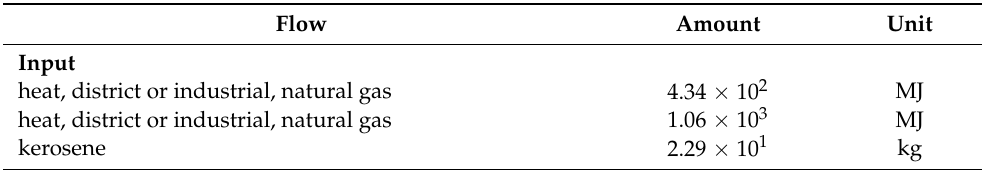
Table A6. Inventory for energy source used for heating the